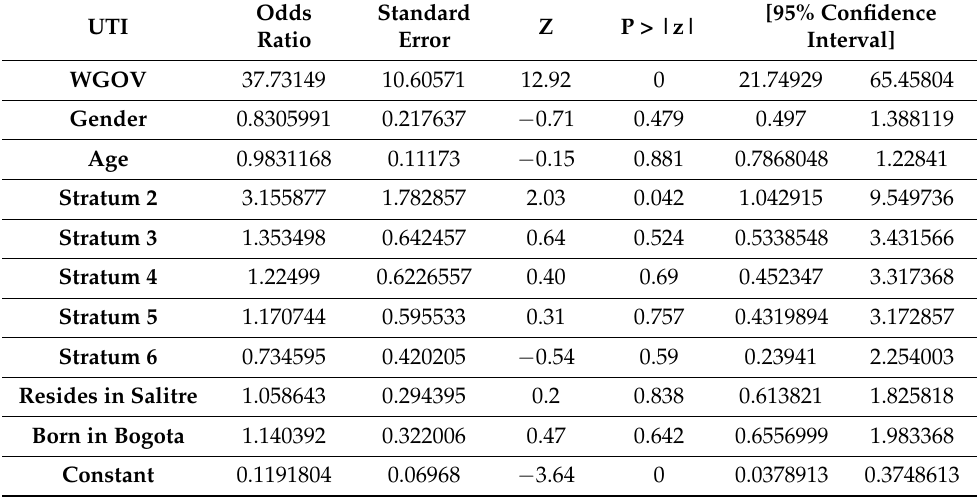
Table 7. Logistic regression a of the effect of weak governance (WGOV) on people’s Unwillingness to Invest (UTI) controlling for gender, age, socio-economic strata, and residence. Odds Standard Z P > |z| UTI Ratio Error